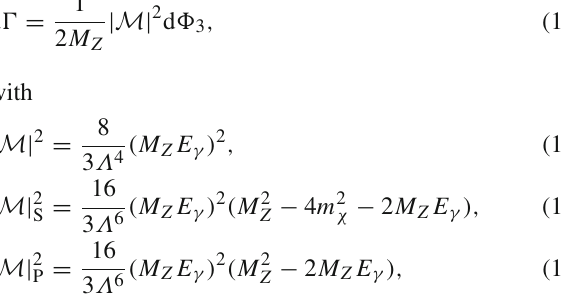
Fig. 2 Δ(cid:13) Z dependence on Λ γ Z (top) at m φ,χ =10 GeV and the nor- · d Δ(cid:13) / d E γ (bottom) for light malized photon energy spectrum Δ(cid:13) − 1 Z Z DM masses with Λ γ Z fixed at 200GeV. The blue, red, green solid/dash lines denote scalar DM and fermion DM with scalar(S) and pseudo- scalar(P) types, respectively. The solid and dash lines denote DM mass at 10 and 30GeV, respectively. The black lines (top) denote Δ(cid:13) Z = 2 . 6 (LEP), 2 . 1 × 10 − 1 (Giga Z) and 2 . 1 × 10 − 2 (Tera Z) MeV. The lat- ter two are estimated by scaling from projected CEPC luminosities, as Δ(cid:13) /Δ(cid:13) = ( L / L ) 1 / 2 CEPC LEP LEP CEPC